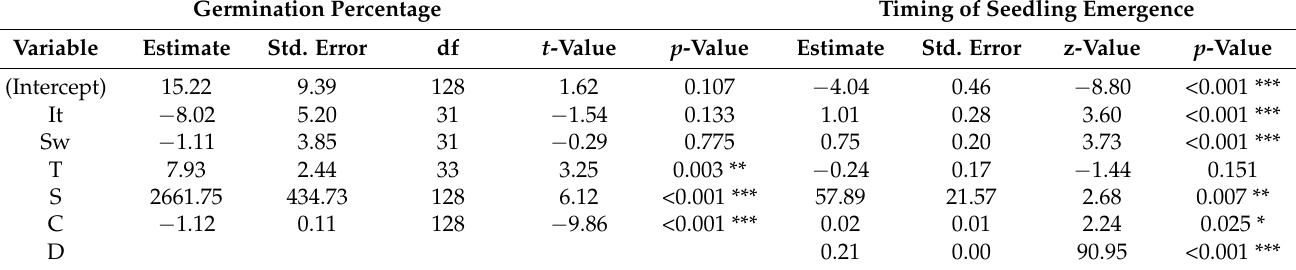
Table 5. Statistical analysis of the germination percentage and the timing of seedling emergence in the spring of 2021. In the model, the Belgian provenance is the standard to which the Italian (It) and Swedish (Sw) provenances are compared, and for the treatment in 2018 (T), the control is the standard to which the water limitation is compared.